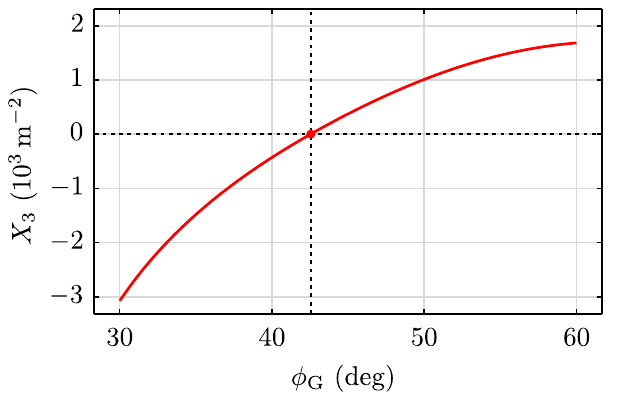
FIG. 8. The coefficient X 3 , describing the third order shift in ζ at z ¼ z , solved for parameter sets determined by X 1 ð z F F Þ ¼ 0 for a gun amplitude E 100 MV = m and gun phase X 2 ð z FIG. 10. Longitudinal phase space of an A STRA simulation F Þ ¼ G ¼ ϕ close to the focus. The bunch length in the focus with an varying from about 30 deg to 60 deg. X 3 is negative for G eliminated third order and a charge of Q ¼ 50 fC is about smaller values and crosses zero at about 43 deg, where a change σ 240 nm, corresponding to 800 as. The prominent wings of sign happens. The third order contribution should hence vanish ζ ¼ ≈ 43 deg as well. for ϕ result from space charge repulsion happening mostly in the G